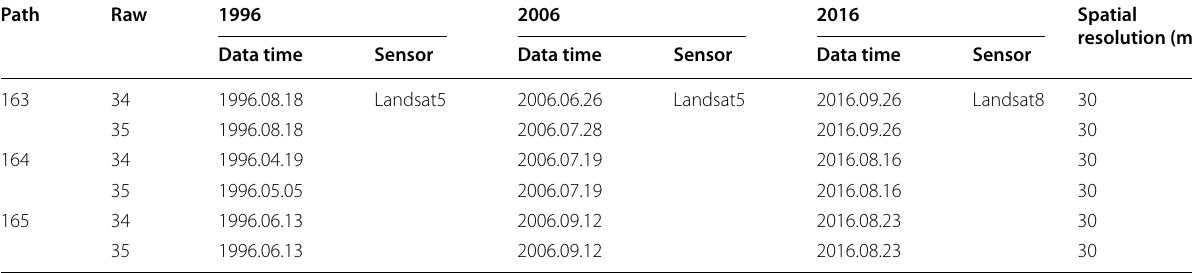
Table 2 Data related to satellite images in the coastal city-region of Mazandaran Path